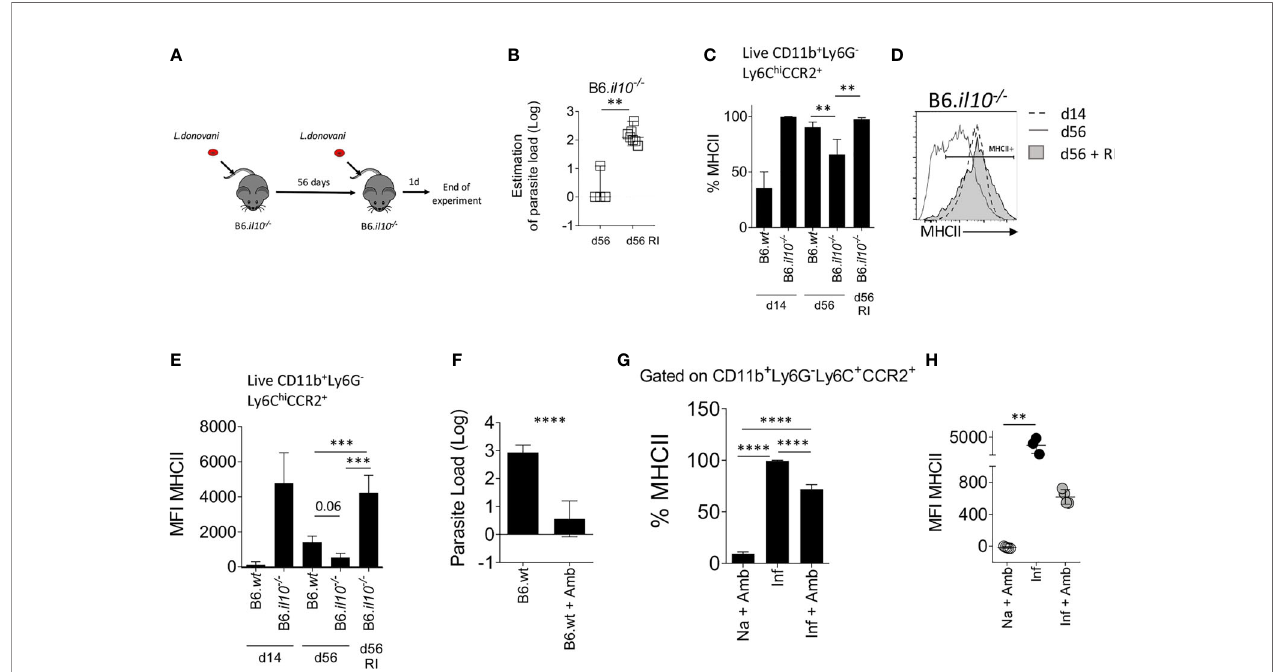
FIGURE 5 | The presence of L. donovani parasites in the BM is necessary to maintain monocyte activation. (A – E) B6 .Il10 -/- mice were re-infected (RI) at d56 with 3x10 7 L. donovani amastigotes and killed 1 day post re-infection. (A) Experimental strategy. (B) Parasite load per one million cells determined by limiting dilution assay in the BM at day 56 or 1 day post RI. Mann-Whitney test applied: P=0.006 (**); 95% CI: 87.73 – 200; statistical power: 100%; n =7. (C) Percentage of MHCII on Ly6C + CCR2 + monocytes in the BM. Brown-Forsythe ANOVA applied only to day 56 data: P=0.0019; statistical power: 99.5%; n ≥ 3; post hoc test Dunnett ’ s T3: statistical difference reached in B6. wt vs . B6. il10 -/- (P=0.0073; **); 95% CI: 5.06 – 44.58) and B6. il10 -/- vs . B6. il10 -/- RI (P=0.0024; **); 95% CI: -51.32 – -12.13). (D) Level of MHCII expressed by the BM Ly6C + CCR2 + monocytes represented on histogram. (E) MFI of MHCII on Ly6C + CCR2 + monocytes in the BM of the indicated mice. Brown-Forsythe ANOVA applied only to day 56 data: P=0.0019; statistical power: 26.7%; n ≥ 3; post hoc test Dunnett ’ s T3: statistical difference reached in B6. wt vs . B6. il10 -/- RI (P=0.0006; ***); 95% CI: -4297 – -1310) and B6. il10 -/- vs . B6. il10 -/- RI (P=0.0002: ***); 95% CI: -5099 – -2266). (F – H) B6 mice infected for 28 days were treated with 10mg/kg of Ambisome ® . Data were collected 3 days post-treatment. (F) Parasite load measured by limiting dilution assay in the BM. Welch ’ s t test applied in (F) P<0.0001; ****; 95% CI: -3.31 – -1.67; statistical power: 100%; n ≥ 6. Percentage (G) and MFI (H) of MHCII expressed on Ly6C + CCR2 + monocytes. Brown-Forsythe ANOVA appliedin (G) : P<0.0001; statistical power: 100%; n ≥ 3; post hoc test Dunnett ’ s T3: statistical difference reached inall pairs (P<0.0001; ****);and Kruskal-Wallistest applied in (H) : P=0.0002; statisticalpower: 100%; n ≥ 3; post hoc test Dunn ’ s MCT inNa+Amb vs . Inf (P=0.0071; **). In (A – E) , data are from 3 to 5 mice per group/experiment. Experiments were performedtwice and pooled data are shown.In (F – H) , data werederivedfrom3 to 4 mice/group. Mean ± SD is shownexceptin A Median with 95% CI